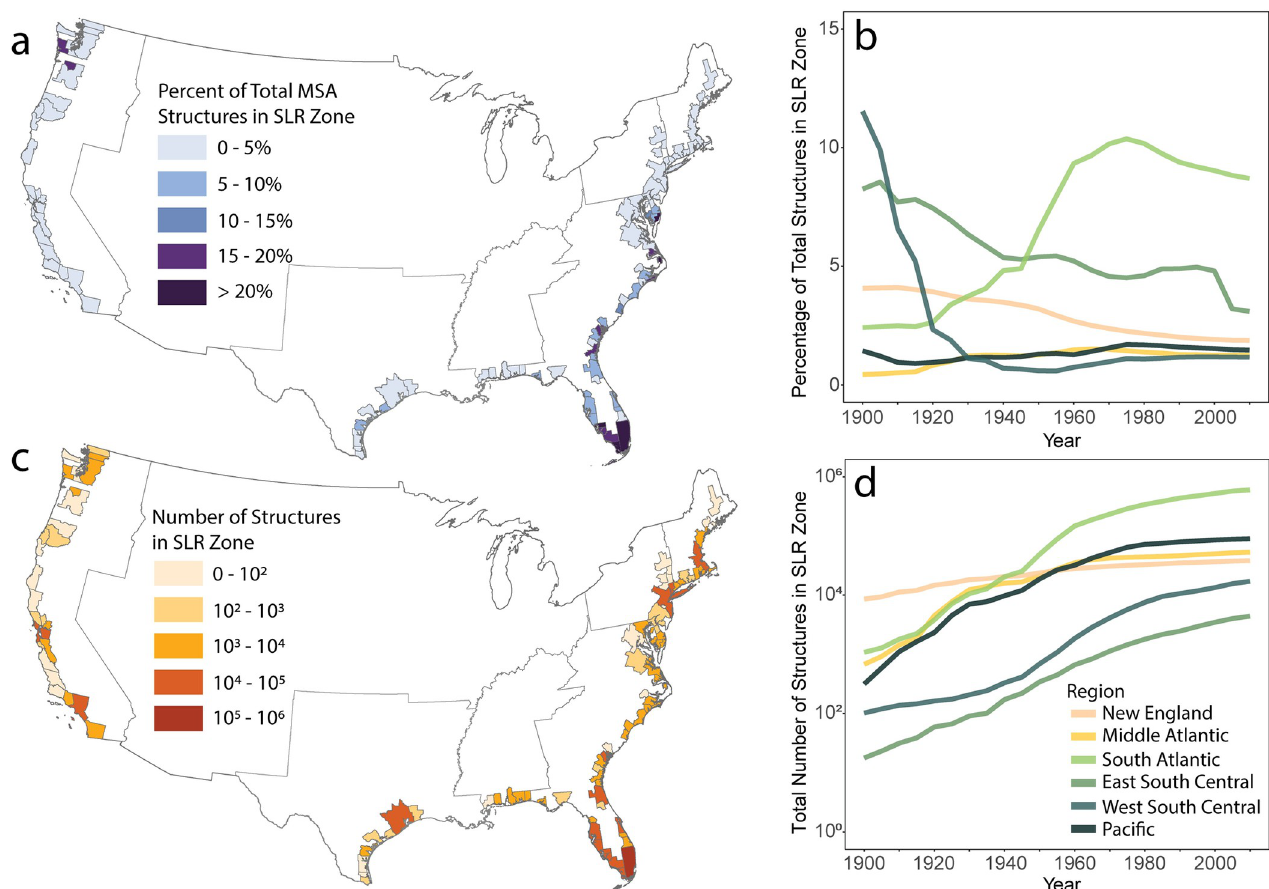
Fig 5. The number of structures in the 6 feet SLR zone is used as an indicator of built environment exposure, illustrating high exposure, particularly in Florida and the South Atlantic division. Relative built environment exposure (the percentage of total structures in the MSA contained in SLR zone) is depicted in MSAs in 2015 (a) and over time by Census Division (b). Absolute built environment exposure (absolute number of structures in SLR zone) is illustrated by MSA in 2015 (c) and over time by Census Division (d). All data used in figure available through an open license for U.S. government datasets [34] or through a CC0 license